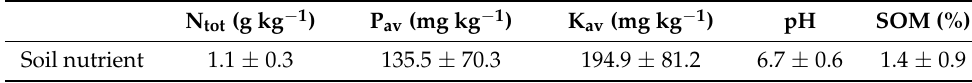
Table 4. Soil nutrient conditions in 2016 for Beiquan Village, Hebei,